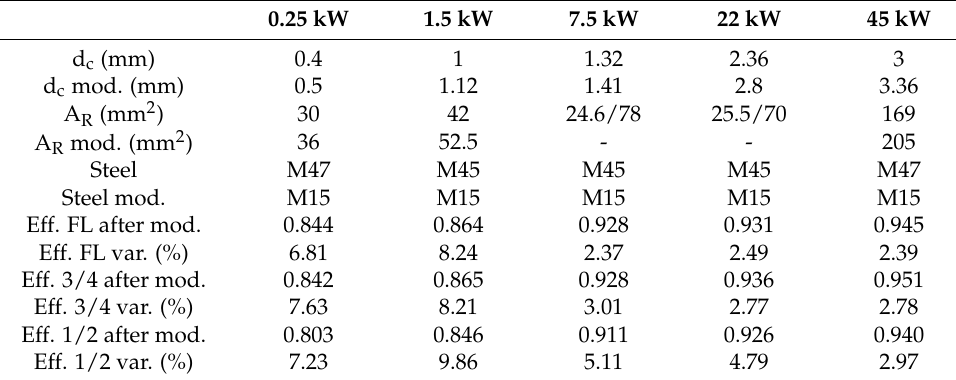
Table 11. Efficiency improvement